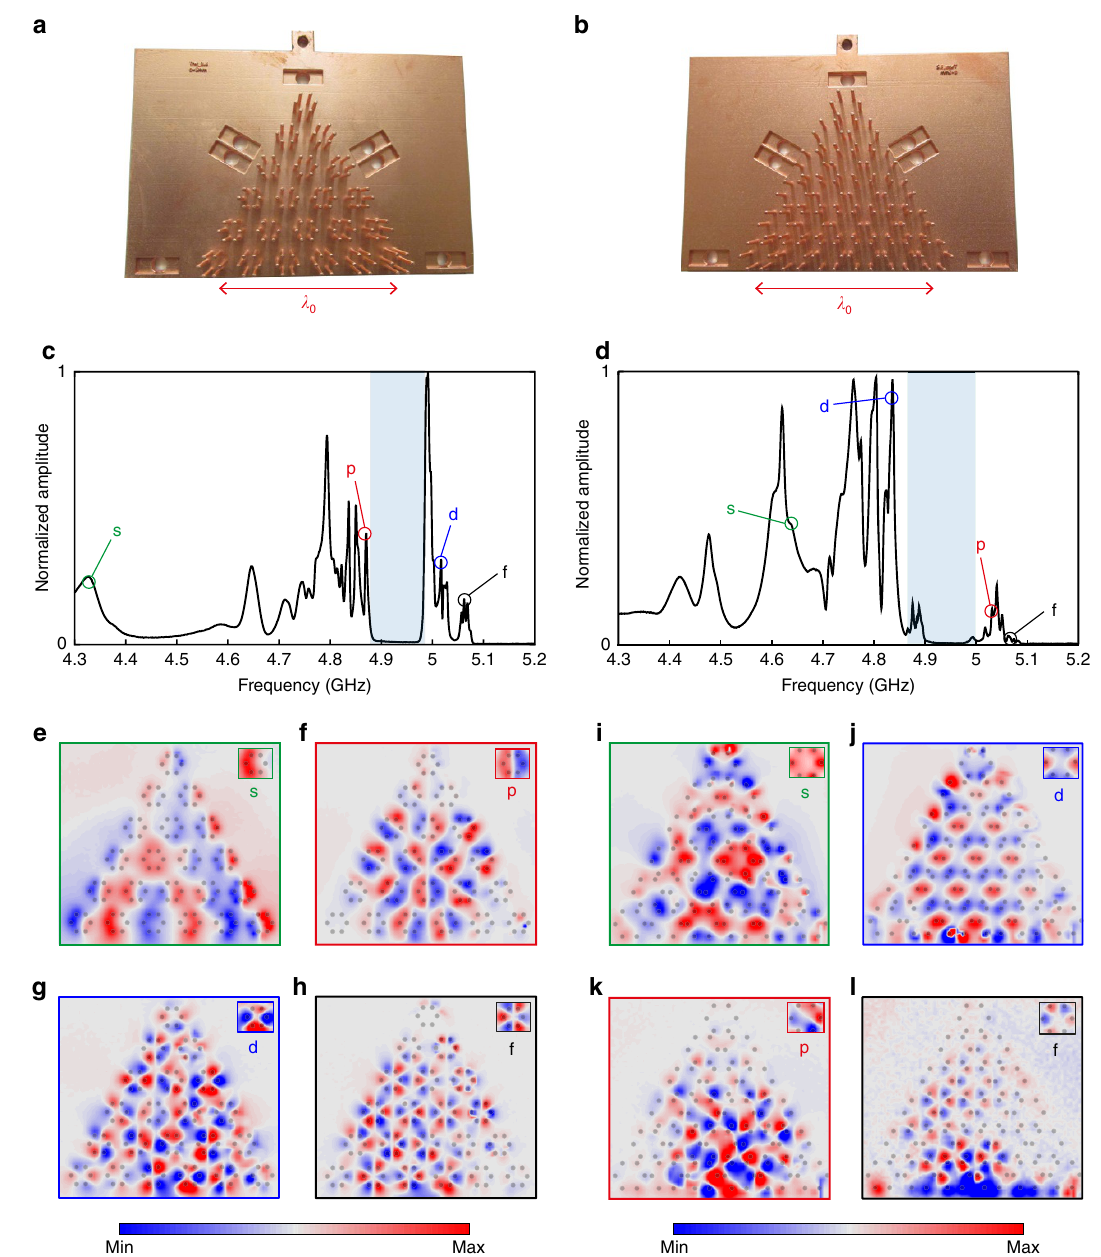
Figure 3 | Experimental validation of subwavelength, topologically nontrivial phases. We have fabricated by 3D printing followed by chemical metallization two subwavelength sized samples composed of conducting rods on a ground plane. ( a ) Picture of the topologically trivial sample made of shrunk hexagons. ( b ) Picture of the topologically nontrivial sample made of expanded hexagons. ( c ) Electric field amplitude spectrum in the bulk of the topologically trivial sample (spatially averaged). A complete band gap is observed (shaded frequency range). Outside of this gap, peaks correspond to efficient excitation of s, p, d and f type bulk Bloch modes, as confirmed by the electric field maps at these frequencies ( e , f , g , h ). ( d ) Same as ( c ) for the topologically nontrivial sample, demonstrating the topological band inversion phenomenon induced by subwavelength structural deformations, with the order of appearance of the p and d bands reversed with respect to the band gap. ( i , j , k , l ) Same as ( e , f , g , h ) for the topologically non-trivial